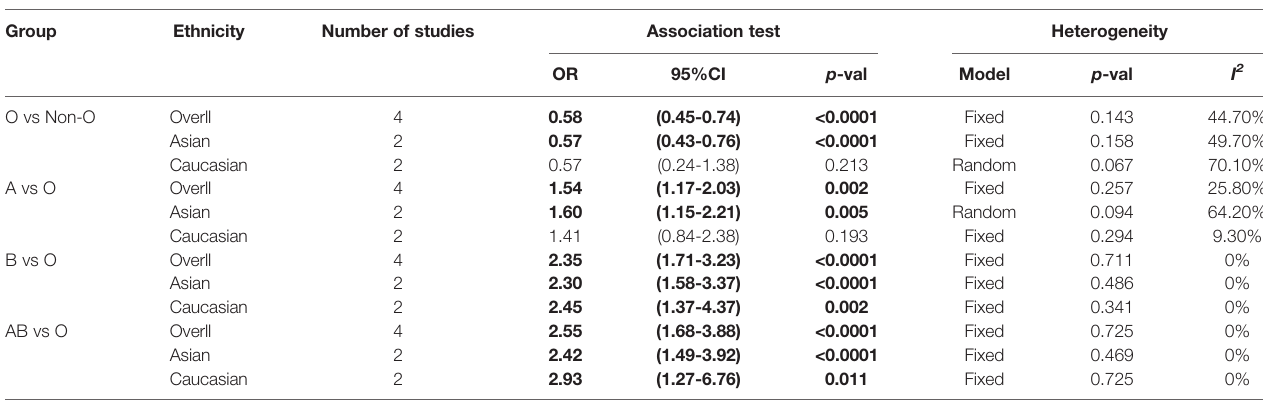
TABLE 2 | Results of ethnic subgroup analysis.